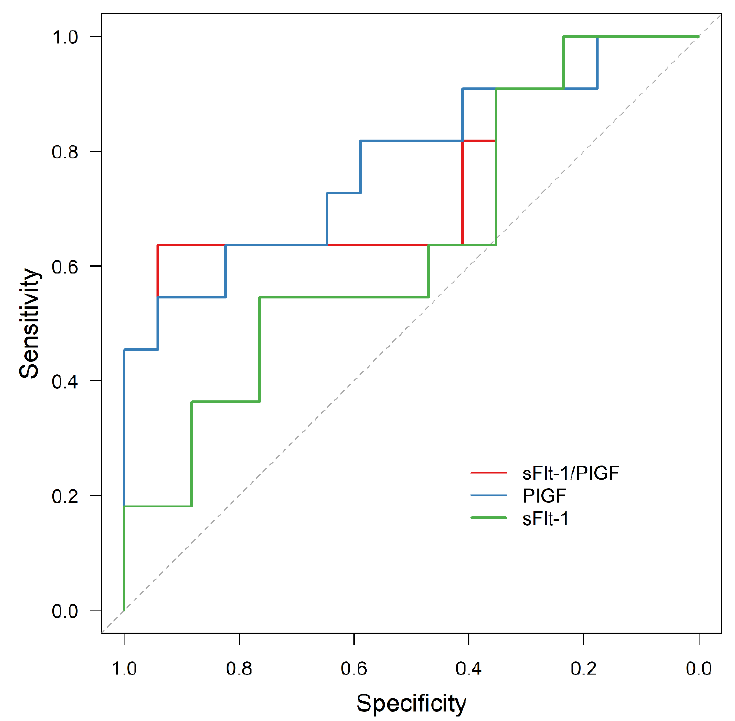
Figure 7. ROC curve for APO prediction in the subgroup of obese women by sFlt-1 (AUC = 0.642, 95% CI: 0.428–0.855, p = 0.213), PIGF (AUC = 0.781, 95% CI: 0.596–0.966, p = 0.014) and sFlt-1/PIGF (AUC = 0.754, 95% CI: 0.552–0.956, p = 0.025). ROC receiver operating characteristic, APO adverse perinatal outcome, sFlt-1 soluble fms-like tyrosine kinase-1, PIGF placental growth factor.